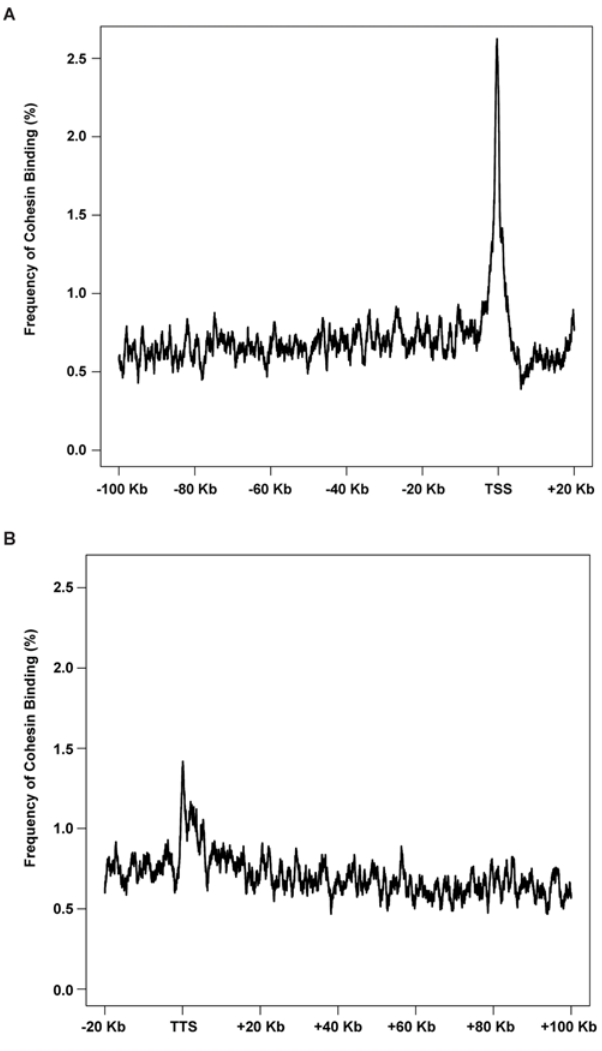
Figure 3. Cohesin binding analyzed in 15,162 unique tran- scripts demonstrates preferential binding to TSSs and TTSs. (A) The frequency of cohesin binding has a sharp peak around TSS and falls to the background level upstream of this peak. (B) The frequency of cohesin binding has another peak around TTS. The height of this peak is about half that of the peak height seen at TSS. Similarly the regions downstream of this peak have a cohesin binding frequency close to the background